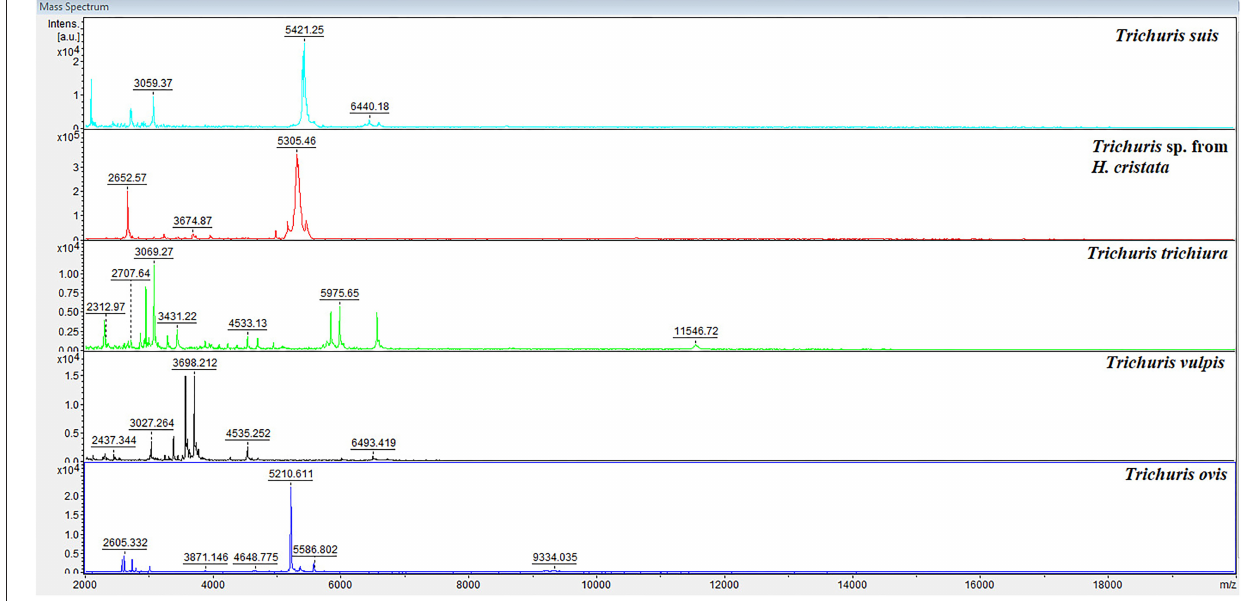
FIGURE 3 | Representative spectral profiles of the esophagus of Trichuris species acquired for the creation of the internal database. a.u., arbitrary units; m / z , mass-to-charge ratio.